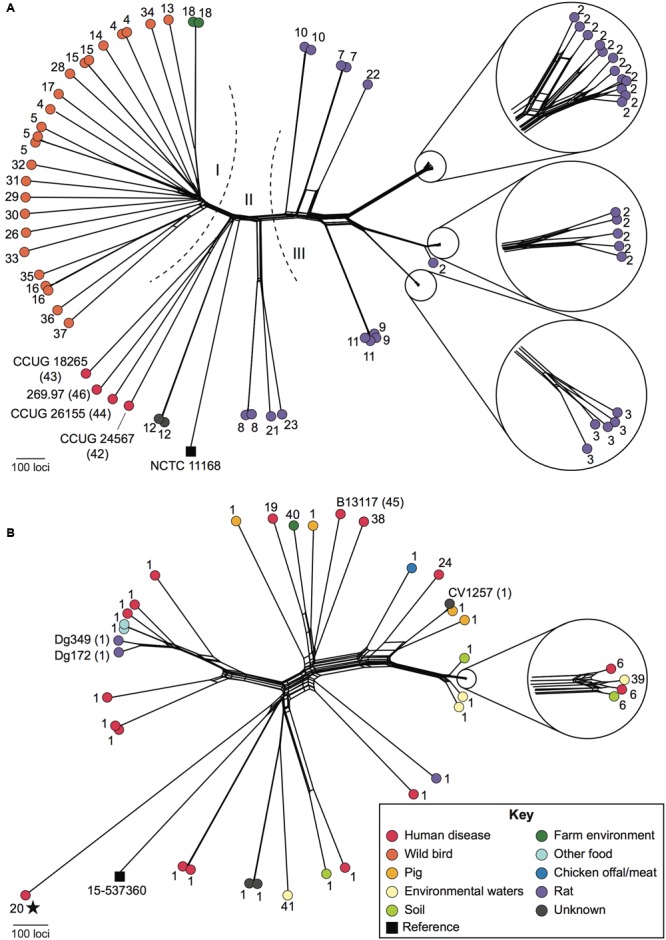
Relationships among ED-positive Campylobacter isolates. NeighborNet graphs were generated based on whole-genome multilocus sequence typing (wgMLST) comparisons of 68 C. jejuni
(A) and 38 C. coli
(B) isolates, using NCTC11168 and 15-537360 (black squares), respectively, as reference genomes. ED allele types are shown as numbers adjacent to each isolate. Isolates included in experiments carried out in this study are labeled in full with the ED type in parentheses. Dashed lines and Roman numerals indicate groups of isolates with related ED types referred to in the text. The color of the filled circles indicates the source of each isolate as shown in the key (inset). All C. coli were assigned to C. coli clade 1 except for a single clade 3 isolate, which is marked with a star.